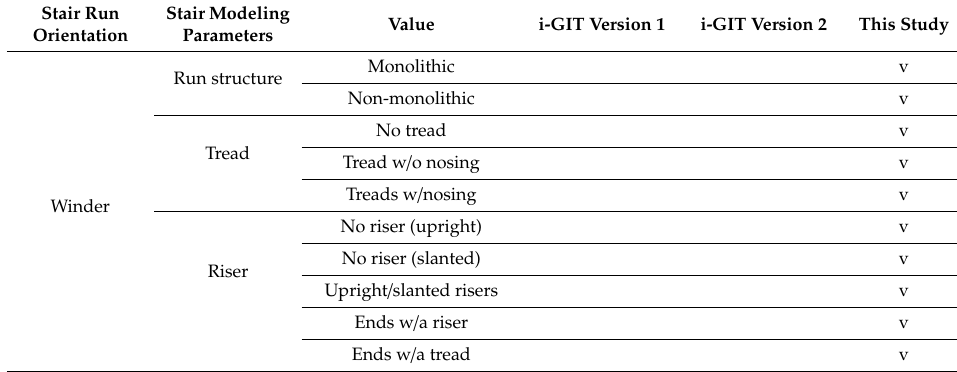
Figure 11. Flowchart for generating a stair flight path. 4.2. Algorithm Logic This section takes the spiral stair in Figure 10(c) as an example to describe the algorithmic logic of the four procedures. 4.2.1. GetPathStartZValue The first procedure for generating a stair flight path is to determine the elevation or Z-value of the path start. This value will be combined with the riser height and used in the following procedures to generate the path start, waypoints, and path end of the path. According to the definition of a path start in Section 4.1, the elevation of a path start should be the maximal Z-value of the slab or stair landing connected to the bottom of the run. GIS and BIM software have a built-in function that can directly obtain the minimal or maximal Z-values of a 3D object. Therefore, to determine the elevation of a path start, one only needs to determine the slab or stair landing connected to the bottom of the stair run, then retrieve its maximal Z-value. However, for those stair runs without physical risers, as shown in the run of Figure 8(a), one cannot find the